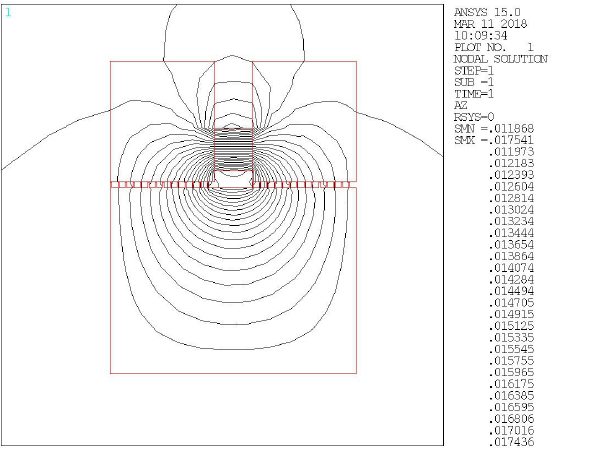
Fig. 12 The distribution of magnetic field lines of the split pole shoes for the optimised